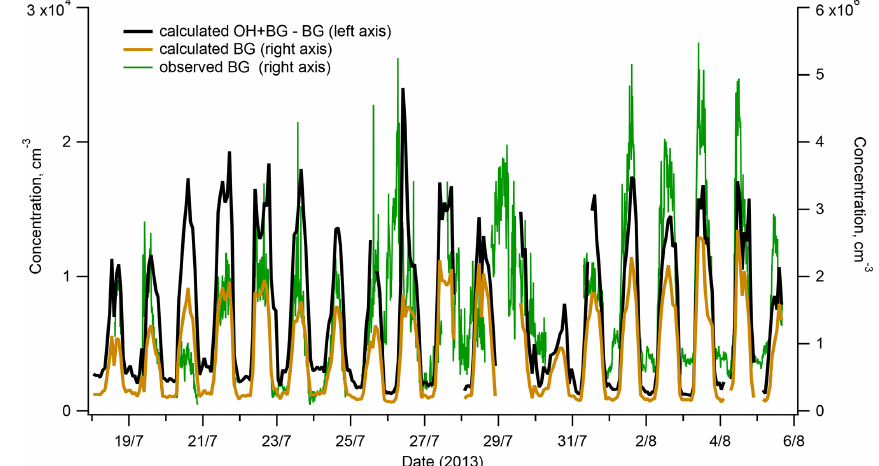
Figure 7. Interference with OH measurements from the H 2 SO 4 produced in the reactor by reactions of SO 2 with SCIs: calculated contribution to measured OH (red line, left axis) and comparison of the observed background (BG) (blue line, right axis) and the BG calculated assuming its origin from the reactions of SCIs with SO 2 inside the reactor (black line, right